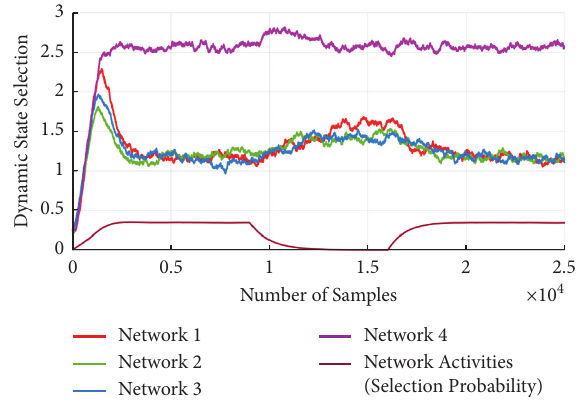
Figure 7: Effect of threshold on network connectivity for � 6 ) . sensitivity � 5 ( V thrl